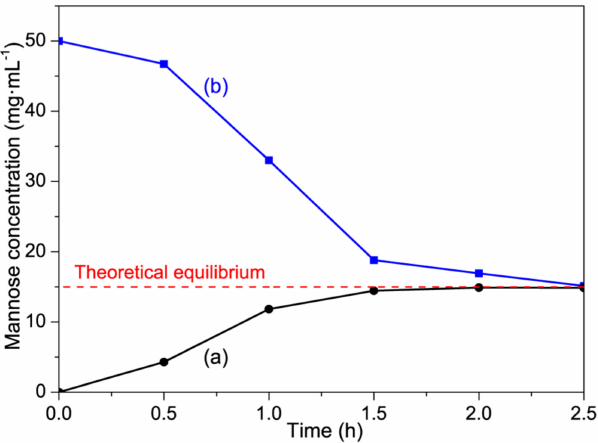
Figure 5. Time courses of epimerization of ( a ) glucose and ( b ) mannose over 13.3PMo / NH 2 -SBA-15. Reaction conditions: 40 mg of catalyst, 5 mL of 5 wt% aldose aqueous solution, 120 ◦